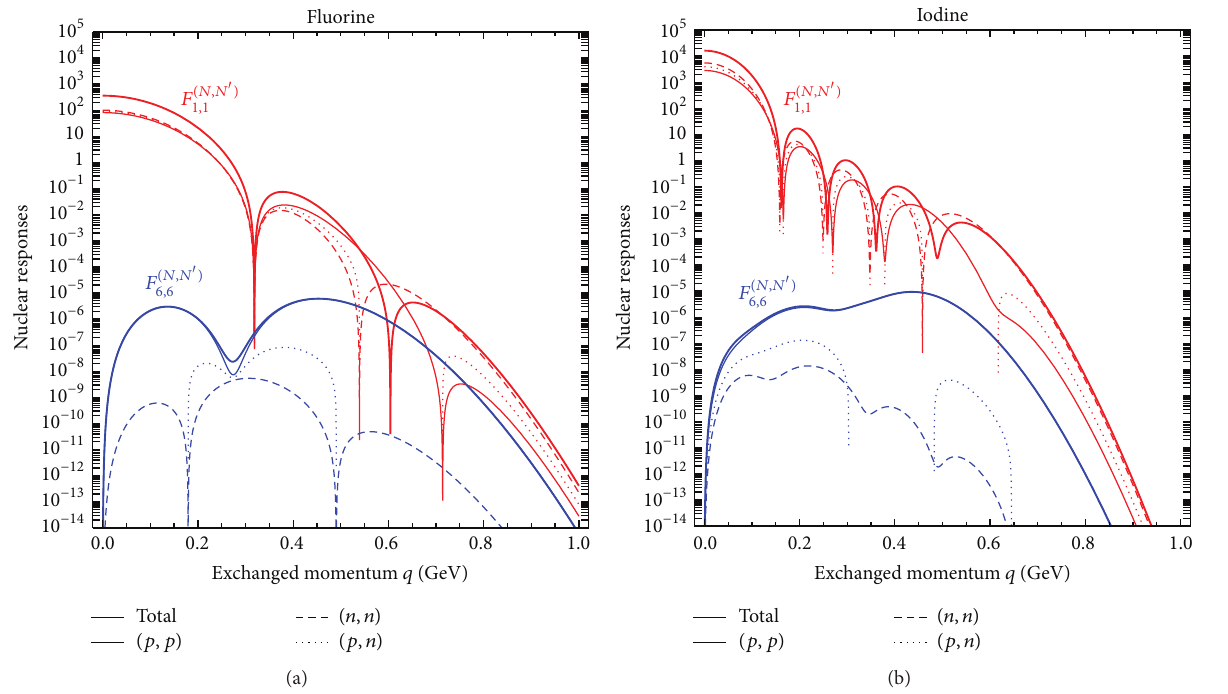
Figure 1: Nuclear responses of the fluorine (a) and the iodine (b) targets considering two completely different types of interactions. On a more specific level, we show, in red, the nuclear responses for the “standard” SI contact interaction, while in blue those for another kind of interaction described in the nonrelativistic limit by the operator O NR 6 = ( ⃗𝑠 𝜒 ⋅ ⃗𝑞)( ⃗𝑠 𝑁 ⋅ ⃗𝑞) . The different hatching refers instead to the possible choices of nucleon pairs in the nucleus. In particular, the solid, dashed, and dotted lines are for (𝑝,𝑝) , (𝑛, 𝑛) , and (𝑝,𝑛) pairs, while the thick ones are obtained by summing over all of them (total nuclear responses). Notice that the total nuclear responses for the “standard” SI contact (𝑞) , where 𝐹 2 (𝑞) is the customary Helm form factor interaction (thick red lines) reduce to 𝐴 2 N 𝐹 2 Helm Helm